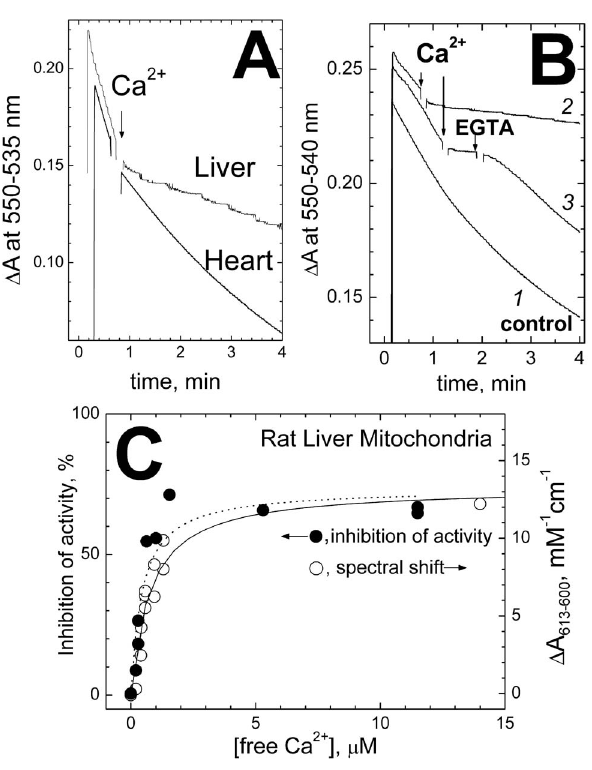
Figure 7. Ca 2 + -induced inhibition of ferrocytochrome c oxidase activity in mitochondria. ( A ) Rat liver (1.3 mg protein/ml) or rat heart mitochondria (0.6 mg protein/ml) in the medium containing 0.25 M sucrose, 50 mM HEPES/tris pH 8.0, 0.4 M choline chloride, 100 m M EGTA, and also 1 m M cyclosporine A and 1 m M the uncoupler, CCCP. 15 m M of the reduced cytochrome c is added and its oxidation is followed at 550 nm vs the 535 nm reference. Ca 2 + addition, 200 m M. ( B ) Rat liver mitochondria. Conditions, as in trace 1 of panel A . Additions: CaCl 2 , 200 m M; EGTA, 300 m M. The traces in the Panels A,B have been displaced arbitrarily on the ordinate scale for clarity. ( C ) Concentration dependences of the Ca 2 + -induced inhibition of COX and spectral shift of heme a in rat liver mitochondria. Cytochrome c 2 + oxidation was measured as in Figure 7B , trace 1 at different concentrations of free calcium buffered with 5 mM HEDTA or 5 mM NTA. The initial slopes of the kinetic curves were used to build the plot. The data have been approximated by a hyperbolic curve (solid line) with the maximal inhibition of 74% and K i =0.76 m M. The Ca 2 + -induced spectral shift of the reduced heme a was measured in an SLM-Aminco-2000C spectrophotometer (see Materials and methods). To decrease light scattering, the mitochondria (10–15 mg protein/ml) were treated with 1% dodecyl maltoside. The data are approximated by a curve (dashed line) with D A 613–600 (max)=13 mM 2 1 cm 2 1 , and K d =0.56 m M.